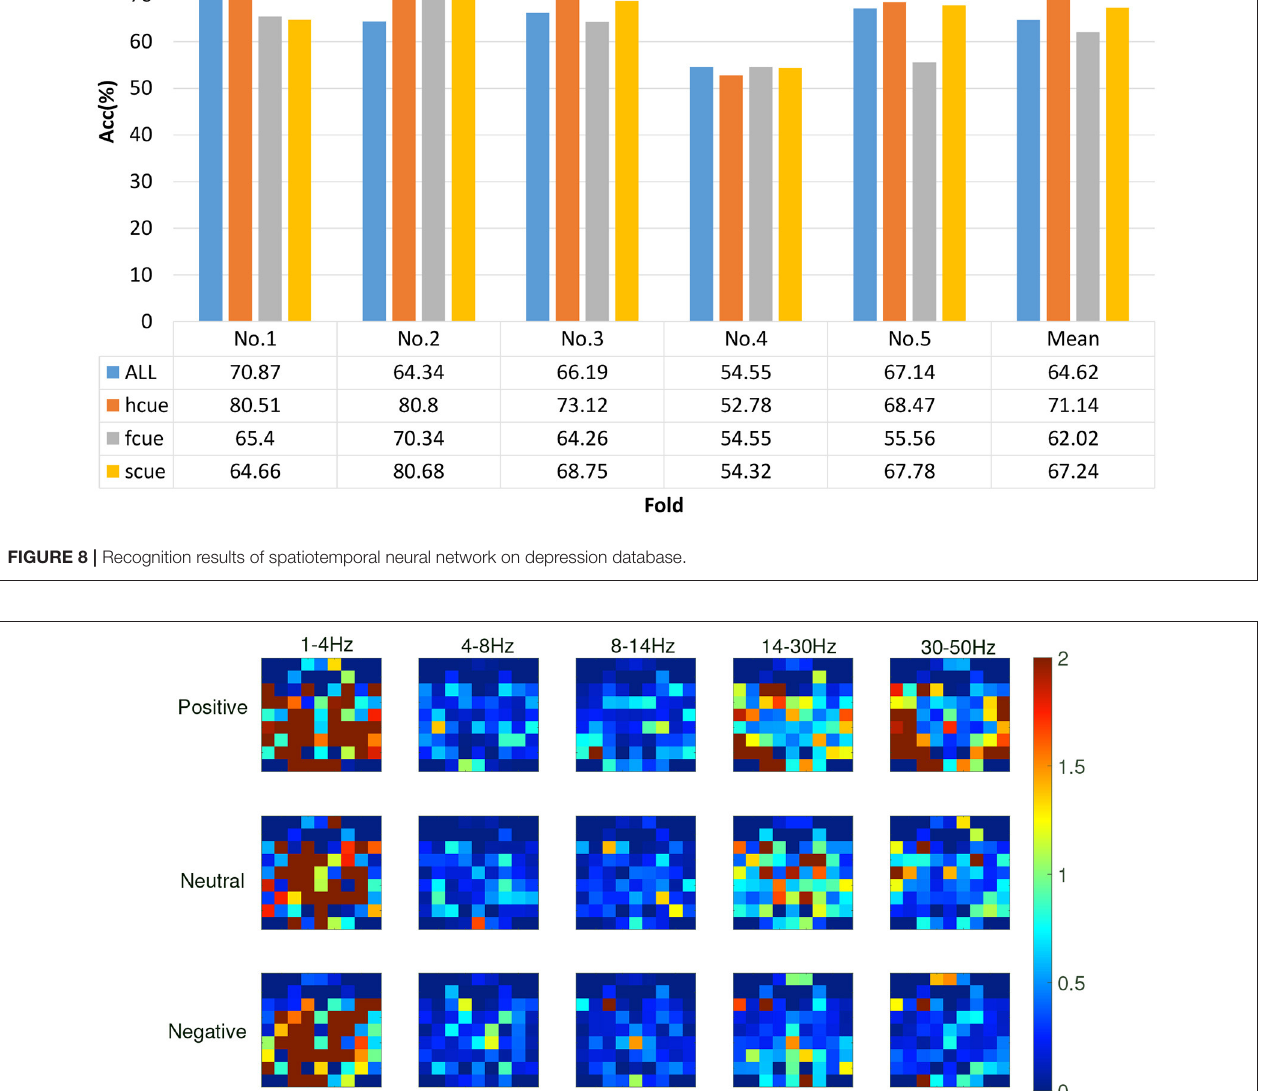
Frontiers in Psychiatry |